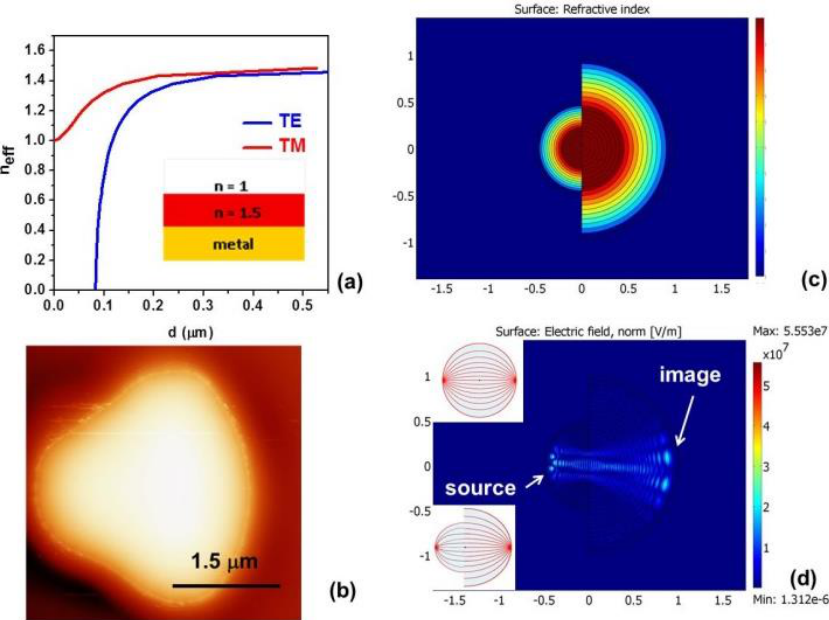
Figure 1. ( a ) Effective refractive index plotted as a function of thickness of a tapered waveguide for TM and TE polarizations. The waveguide geometry is shown in the inset. ( b ) Atomic Force Microscope (AFM) image of a lithographically defined individual magnifying fisheye lens made of two half-lenses of different radii. ( c ) Corresponding spatial distribution of the effective refractive index. ( d ) COMSOL Multiphysics simulation of the fisheye lens image magnification. The insets illustrate ray propagation in the original and the magnifying fisheye lenses.